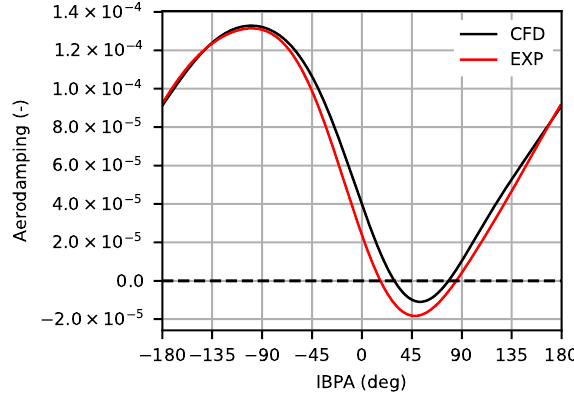
Figure 11. Complex AIC validation— k = 0.4, x / c = 1, φ = 0.2.